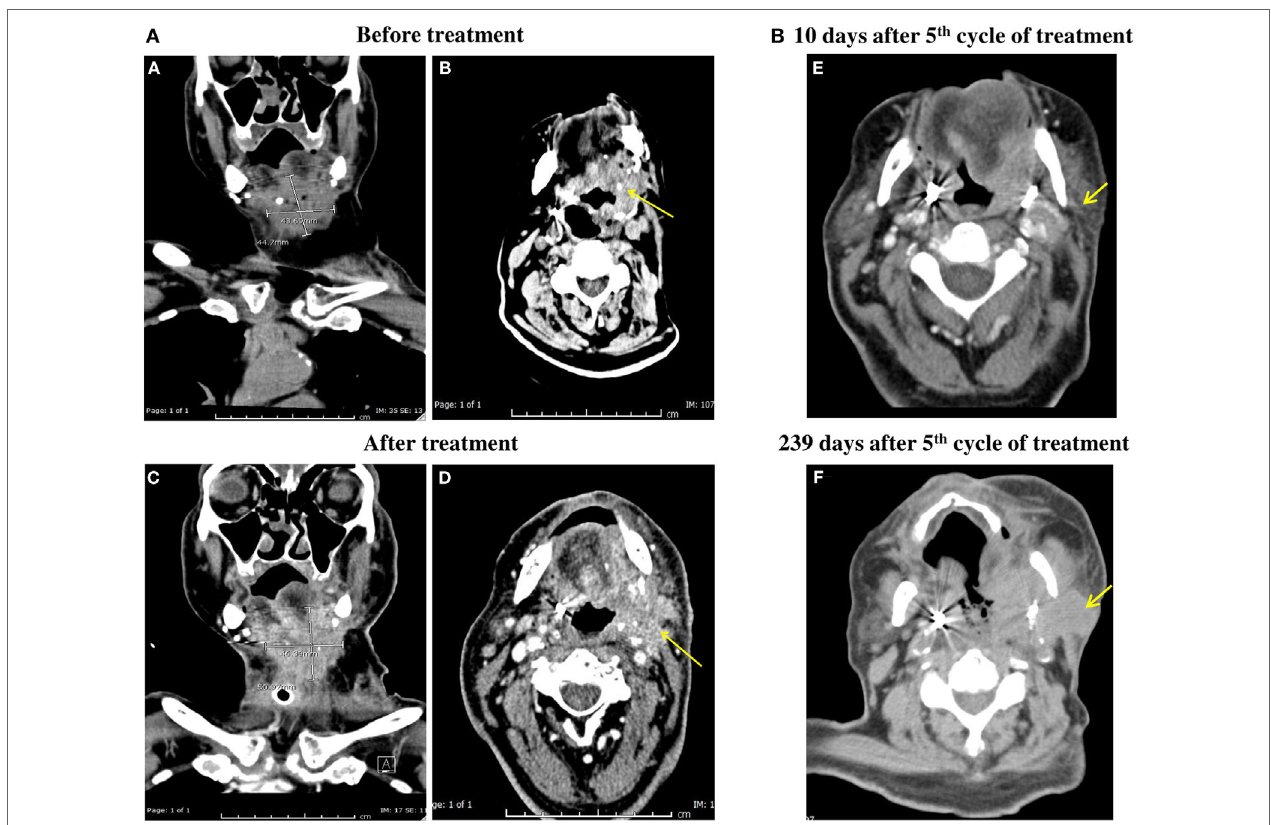
FIgURe 1 | (a) CT scan of the patient neck with IV contrast. Irregular infiltrative mass in the left side of the neck adjacent to the base of the tongue, invading the oropharynx and extending caudally to supraglottic and glottic larynx was shown both before and after the fifth cycle of anti-programmed cell death protein-1 (PD-1) treatment [ (B,D) respectively]. It shows mild increase in size measuring about 5.1 cm × 4.6 cm 10 days after the fifth cycle (C) compared to 4.5 cm × 4.3 cm before anti-PD-1 treatment (a) . (B) PET CT carried out at day 239 after fifth cycle (7 months, 25 days) of anti-PD-1 treatment showing progression of the disease (F) compared tp PET CT obtained at 10 days after the fifth cycle (e)